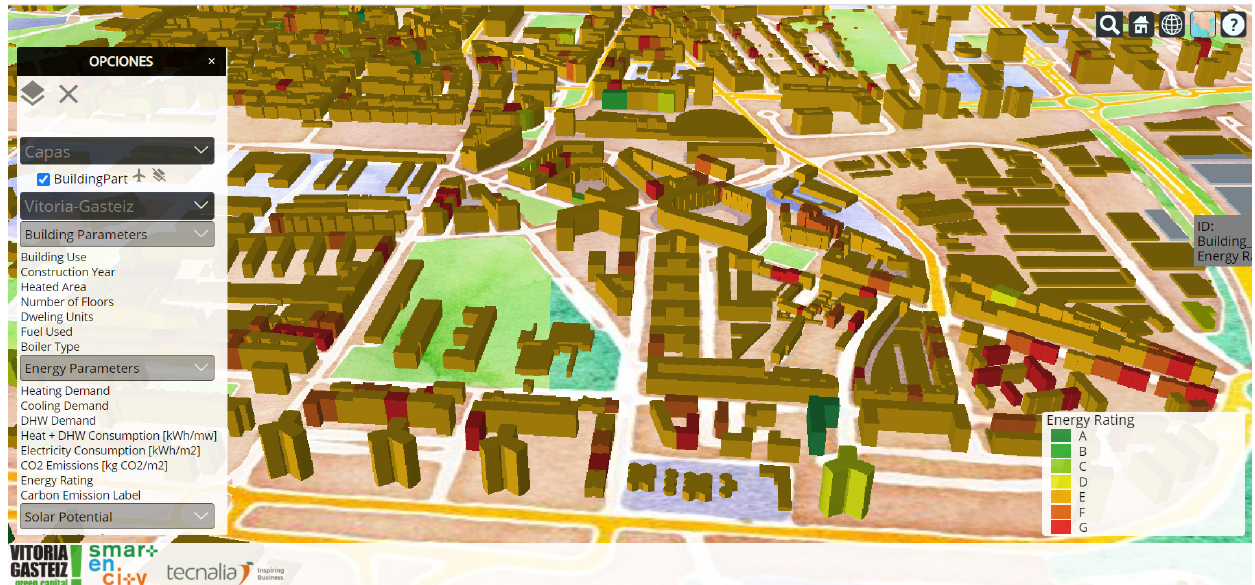
Figure 6. Dashboard for the GIS-based energy services for energy demand and usage